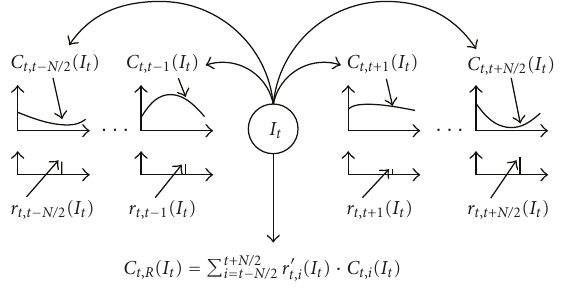
Figure 11: Compensation value C t , R ( I t ) for a specific grey-level I t is obtained by averaging inter-frame compensation values C t , i ( I t ), i ∈ [ t − N/ 2; t + N/ 2] within a temporal window of width N centered at current frame F t . Each inter-frame compensation value is weighted by its associated reliabilty r t , i ( I t ).